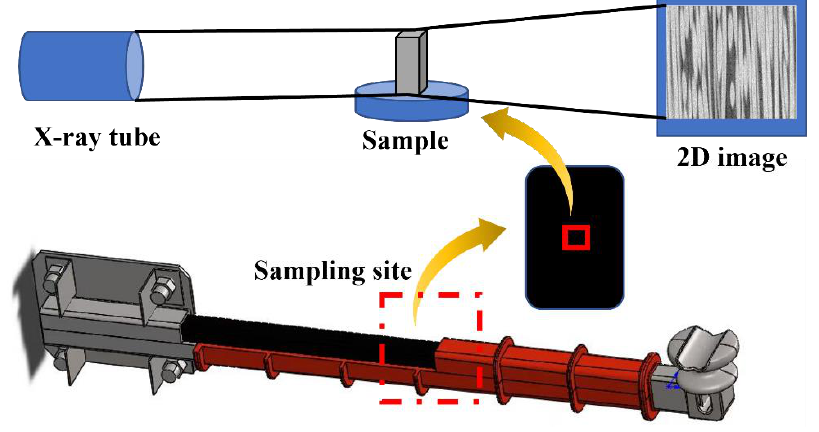
Figure 5. Main stages in X-ray micro-CT.